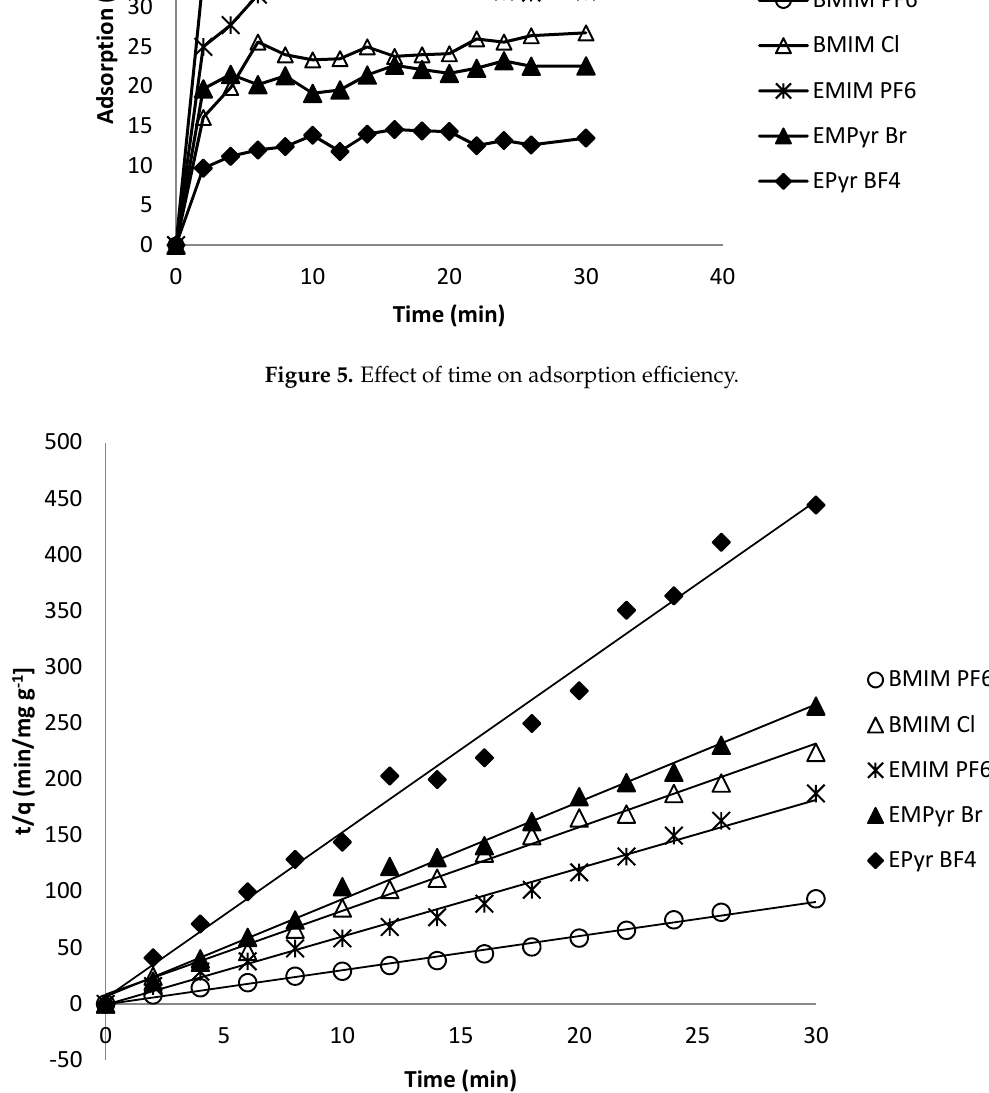
Figure 6. The linearized form of the pseudo-second-order kinetic equation.